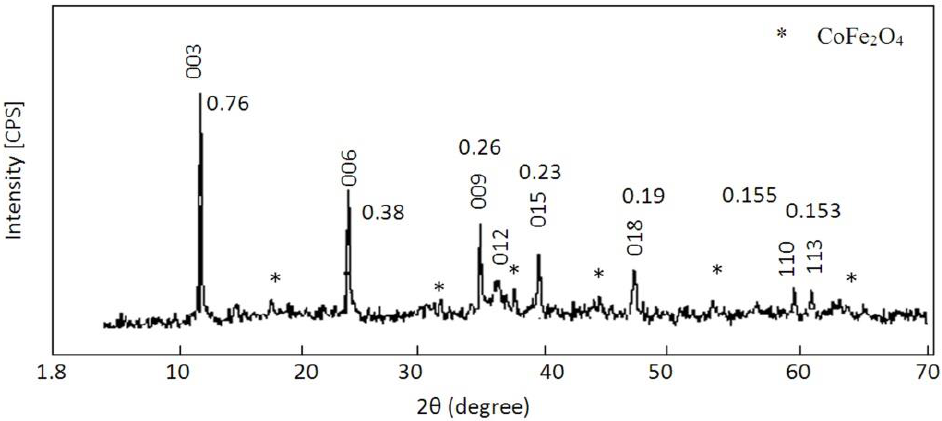
Figure 2. X-ray diffraction pattern of the CoFe 2 O 4 -supported Co-Fe LDH.